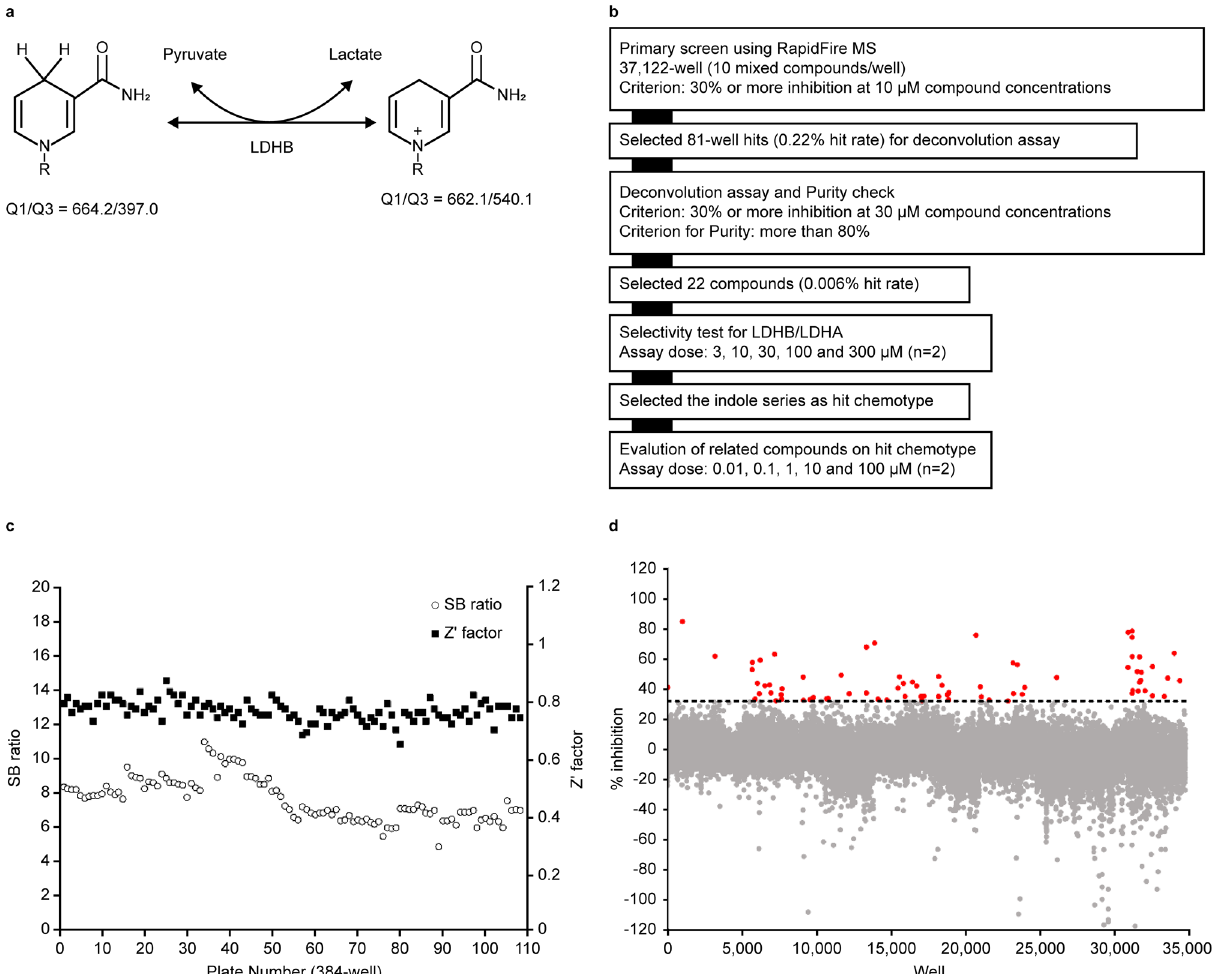
Figure 1. Primary screening for inhibitors of lactate dehydrogenase B (LDHB). ( a) LDHB-catalysed reaction scheme. NADH and NAD + were detected using mass spectrometry, and their respective MRMs are shown. ( b) Screening cascade and the results of primary screening. The high-throughput screening cascade consisted of the primary screening, profiling assay, hit validation, and characterisation. A diverse library of small compounds from Axcelead at 10 µM was screened against LDHB. ( c) SB ratio (open circles) and Z’-factor values (filled squares) of the overall primary screening. ( d) Scatterplots of primary screening data and selection of hit wells exhibiting greater than 30% inhibitory activity (red